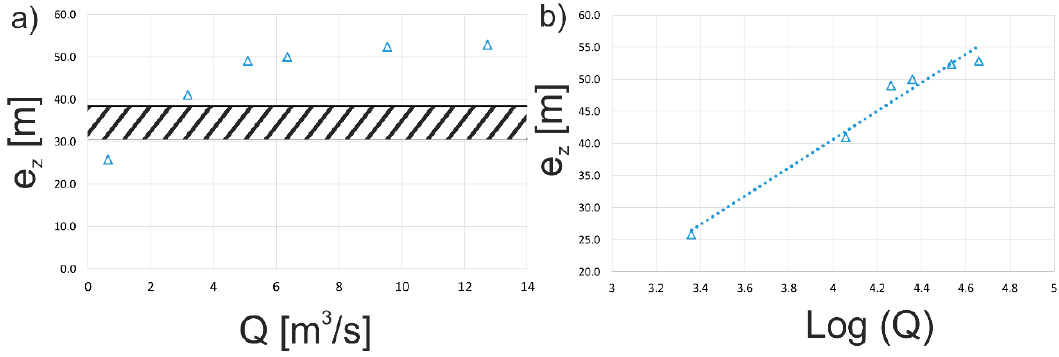
Figure 11. ( a ) Effective zone (e z ) versus flow rate (Q) for scenario 4. The shaded zone indicates the recommended distance (4 √𝑆 to 6 √𝑆) between the duct end and the face; ( b ) the effective zone (e z ) versus the log flow rate (Q) for scenario 4.